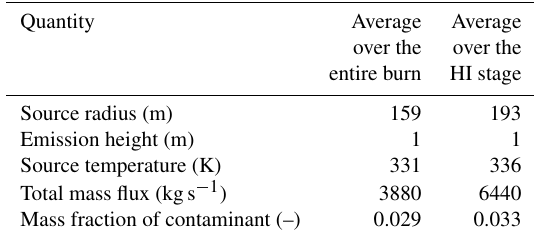
Figure 3. Measured temporal evolutions of the fire radiative power (FRP) (red curve, left-hand vertical axis) and the active fire area (black curve, right-hand vertical axis) of the L2F burn. The FRP values were taken from the data presented by Hudak et al. (2016a). WASP refers to Wildfire Airborne Sensor Program. Transects of the measurement aircraft are denoted by four vertical bars colored light red and violet (marked as PG 1, CS 2, PG 2, and PG 3); data extracted from Urbanski (2014b). PG and CS refer to the parking garage and corkscrew flight maneuvers, respectively. Time- averaged values of FRP and the active fire area are shown with dashed red and black lines, respectively.